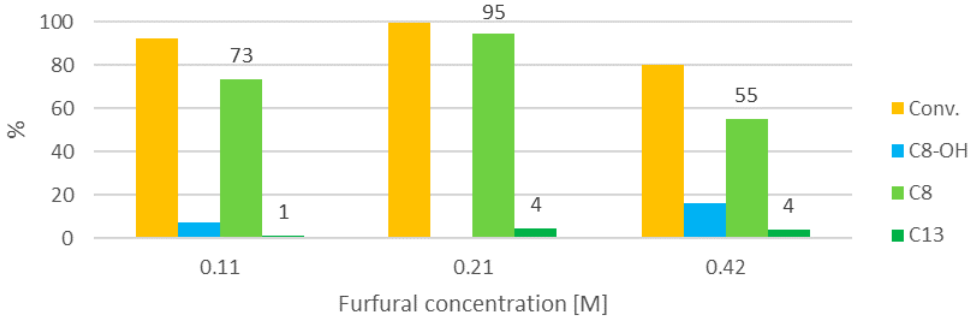
Figure 5. Influence of furfural concentration (at 100 °C, 30 min, furfural:HT 2:1).